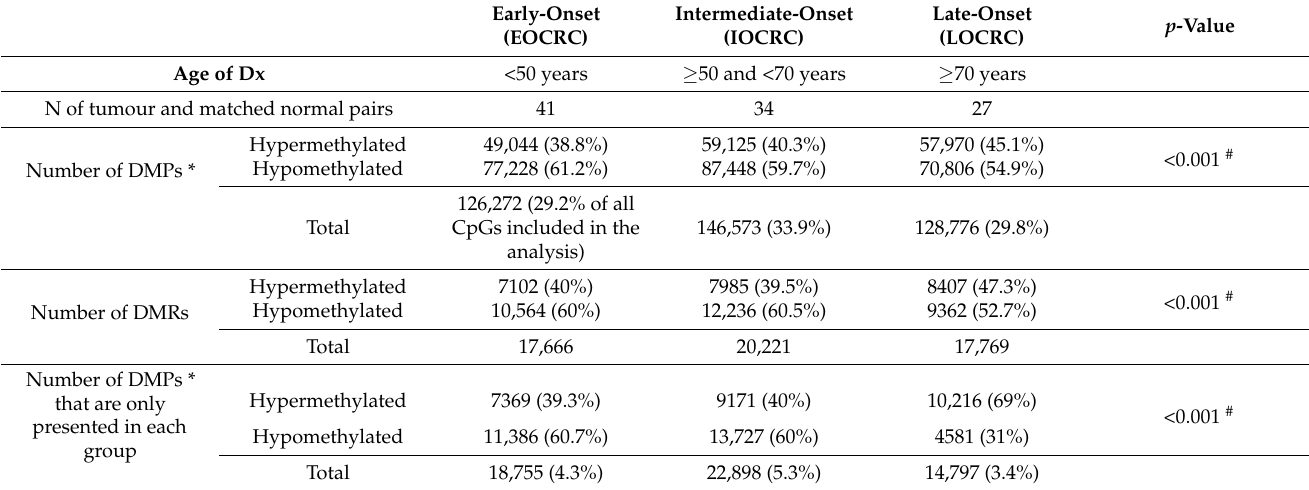
Table 2. Numbers of differentially methylated probes (DMPs) and regions (DMRs) identified between tumour and normal pairs from EOCRC, IOCRC, and LOCRC cases included in the